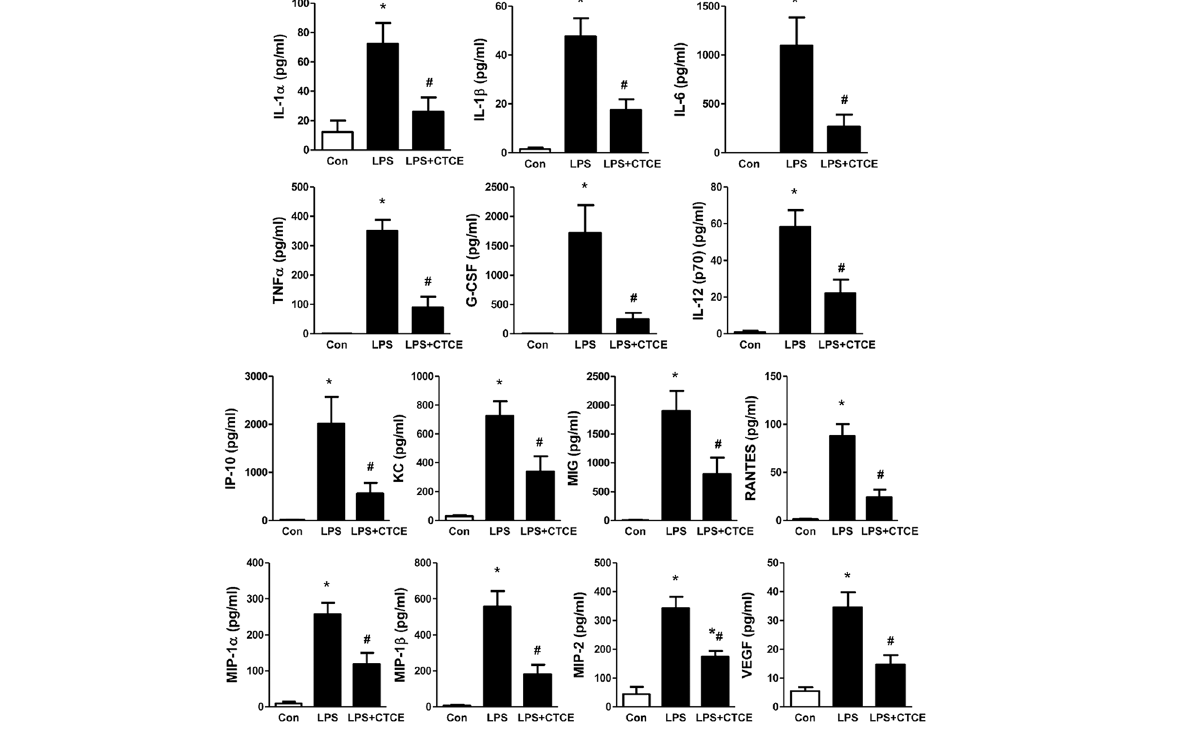
Figure 7. CTCE decreased BAL cytokine and chemokine levels in LPS-induced ARDS. See Figure 6 for method. BAL cytokine and chemokine and growth factor levels were determined by mouse cytokine and chemokine array. * p < 0.05 compared with control group, # p < 0.05 compared with LPS groups. N = 6–9